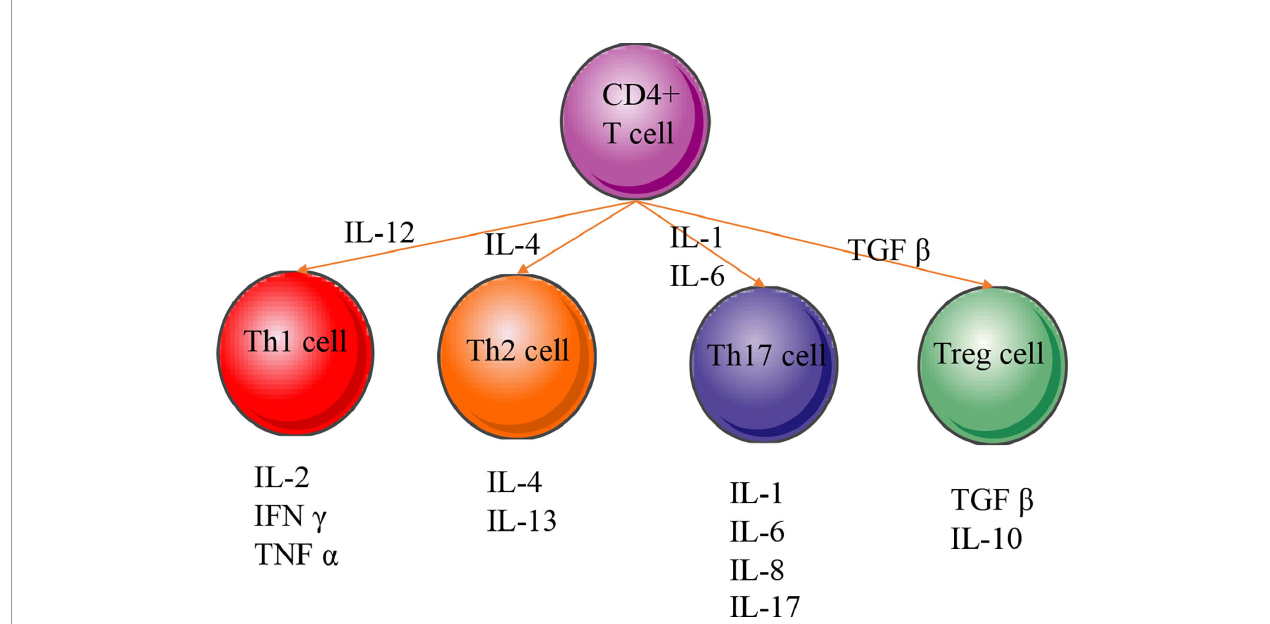
FIGURE 6 | CD4+ T-cell differentiation and cellular phenotype. Naive CD4+ T cells differentiate into many different types of T helper (Th) or regulatory T (Treg) cells. The regulating transcription factors of subsets and their characteristic effector cytokines are indicated in the fi gure. IL ‐ 1, interleukin ‐ 1; IL ‐ 2, interleukin-2; IL ‐ 4, interleukin ‐ 4; IL ‐ 6, interleukin ‐ 6; IL ‐ 8, interleukin ‐ 8; IL ‐ 10, interleukin-10; IL ‐ 13, interleukin ‐ 13; IL ‐ 17, interleukin ‐ 17; IFN- g , interferon gamma; TNF- a , tumor necrosis factor alpha; TGF- b , transforming growth factor